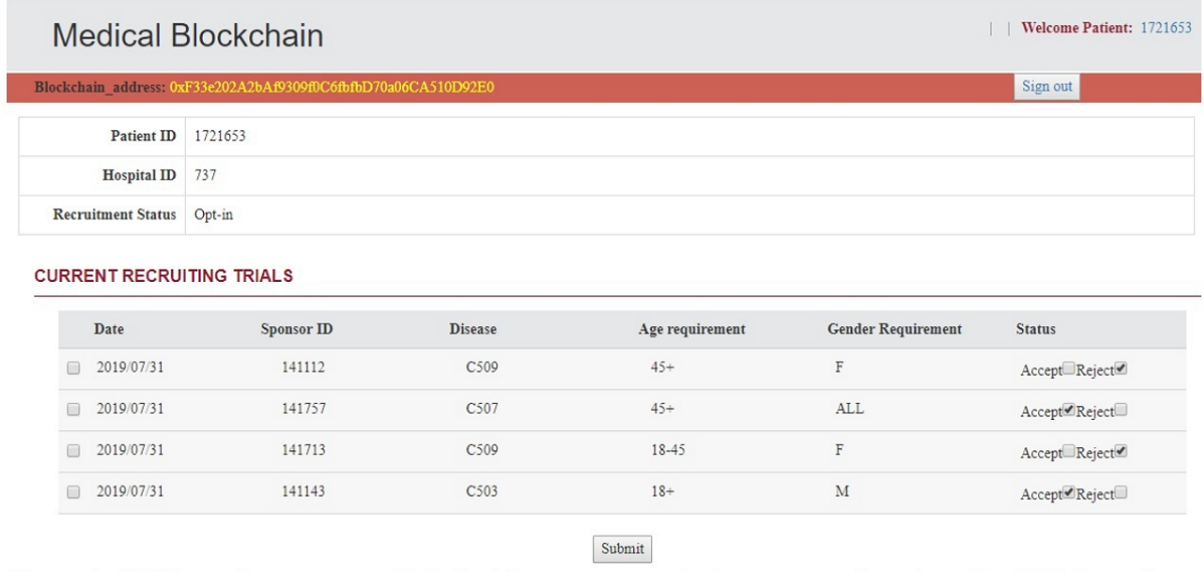
Figure 6. Graphical user interface for patients to permit clinical trial sponsors to access their data. The graphical user interface shows the patient’s blockchain address, opt-in status, current recruiting trials’ basic recruitment criteria, and permission options. When the patients select the recruiting trial and click submit, the sponsor will be added to their access list in the USER manager smart contract through the blockchain